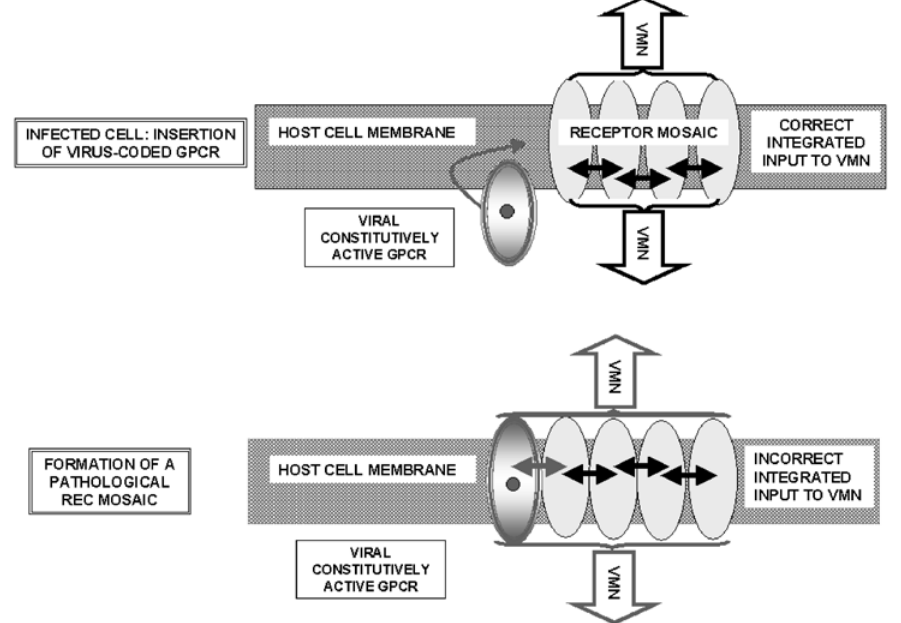
FIGURE 3. A virus-carried GPCR can be inserted into the host cell plasma membrane and redirect a host cell RM. For further details, see